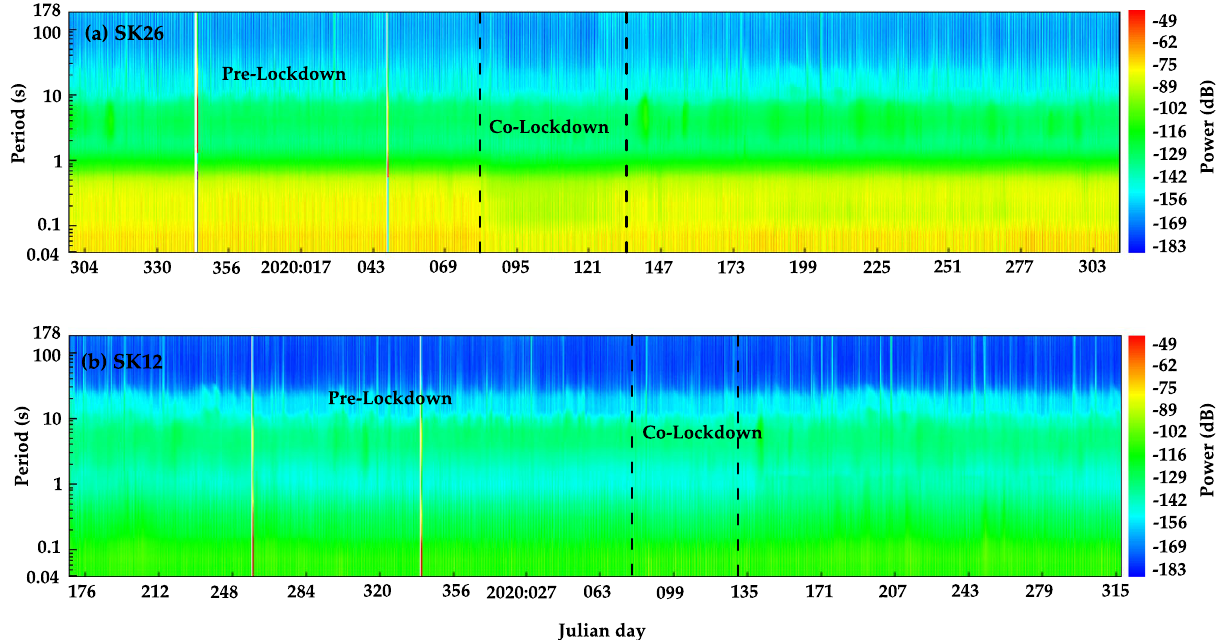
Figure 9. ( a ) Spectrogram plot at station SK26 to study the variations in noise due to the global COVID-19 pandemic. Spectrogram illustrates the noise level for the entire duration of data collection at the station. A decrease in short-period noise between Julian days 81 to 130 (March 22–April 22 2020). ( b ) Spectrogram plot at station SK12. No visible variation in noise is observed during the lockdown period since the station is situated in a remote